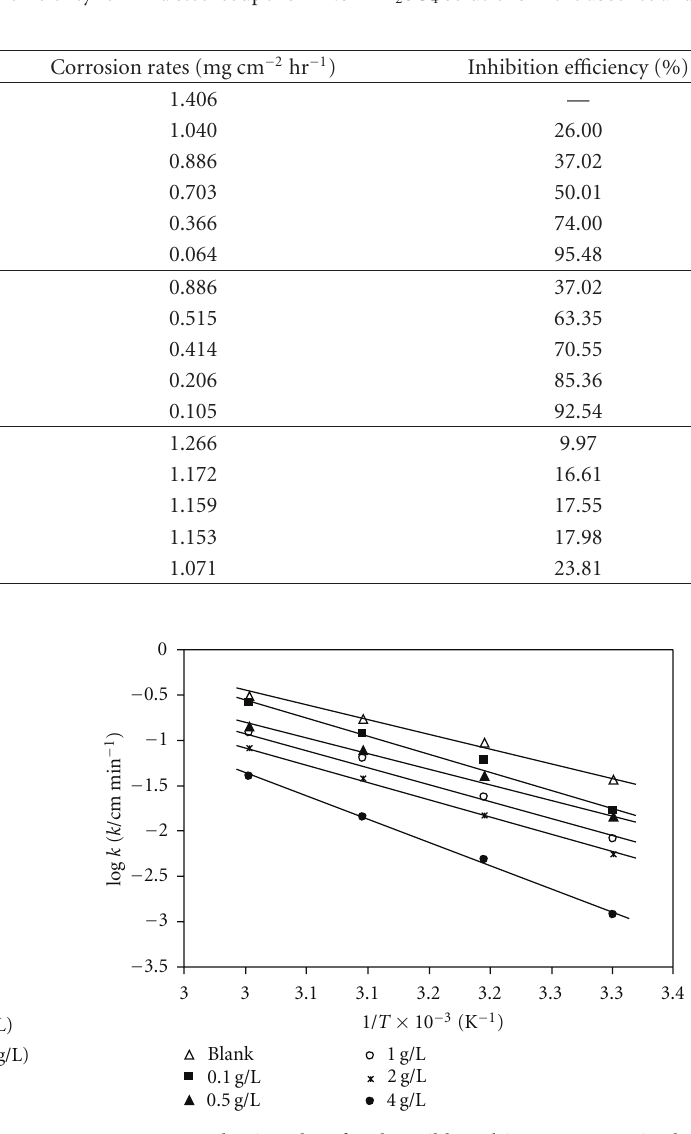
Figure 4: Arrhenius plots for the mild steel in 5M H 2 SO 4 in the absence (Blank) and presence of